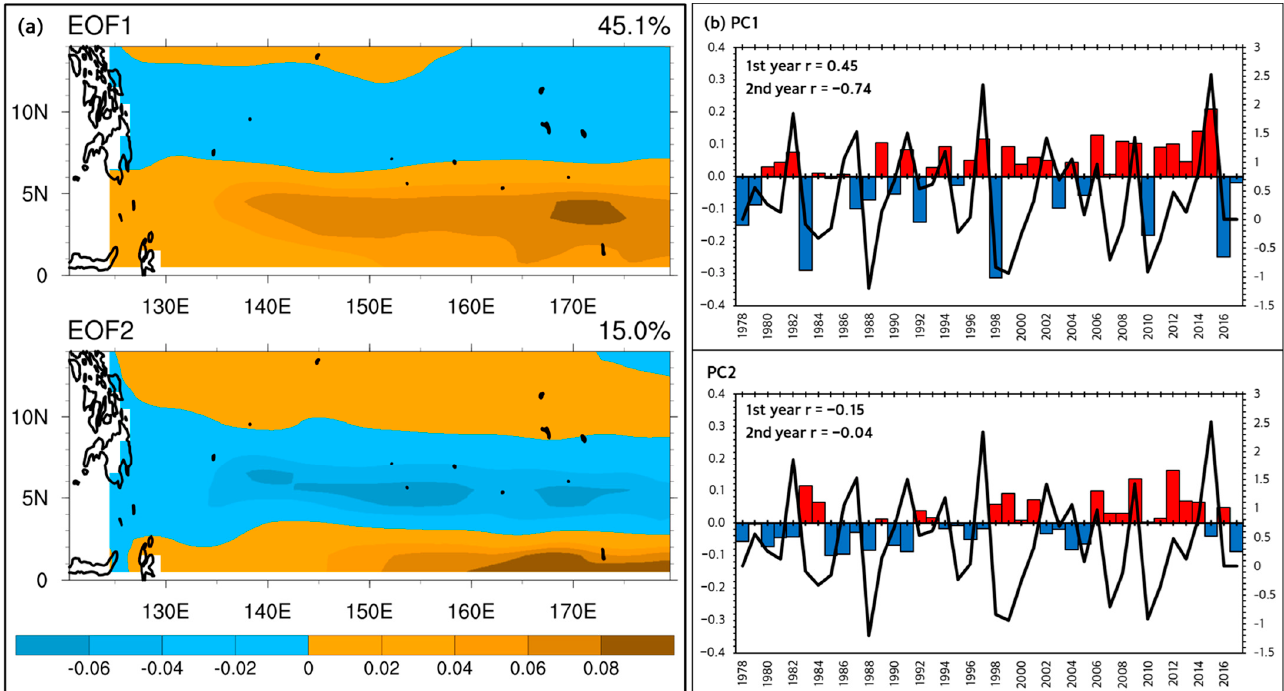
Figure 4. The first and second EOF modes of boreal spring (MAM) zonal current geographical distribution ( a ), and associated time series PC from 1978 to 2017 overlaid with the NIÑO 3.4 indices (black line) ( b ). In ( b ), the positive and negative values denote the greater and weaker NECC magnitudes, respectively.